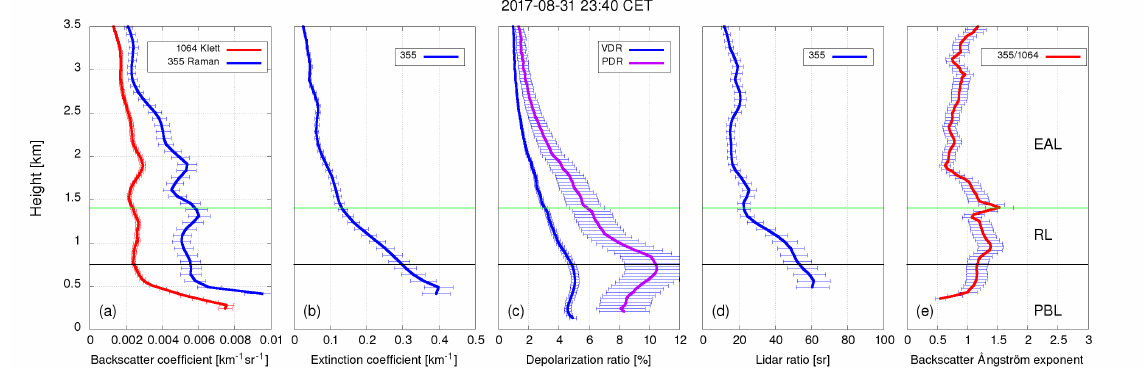
Figure 5. Aerosol optical properties obtained from LiDAR data in stable atmosphere on 31 August 2017 at 23:40–00:10(+1) CET. ( a ) BS coefficients at 1064nm (red) using Klett and at 355nm (blue) using Raman method; ( b ) extinction coefficient at 355nm; ( c ) VDR and PDR at 355nm; ( d ) LR at 355nm and ( e ) the BAE between 355 and 1064nm. Error bars represent total uncertainty of each presented quantity. Horizontal lines (black and green) indicate the boundaries between different elevated aerosol layers. Table 2. Aerosols in the three observed atmospheric layers (PBL, RL and EAL) were characterized using observables sensitive to intrinsic aerosol properties. Particle depolarization ratio (PDR) and LiDAR ratio (LR) were obtained at 355nm, while the backscatter Ångström exponent (BAE) was retrieved using both 355nm and 1064nm backscattering coefficients. Predominant aerosol type in each layer was chosen based on the values of aerosol optical properties of particular aerosol types, investigated in reference papers, listed in the last column.